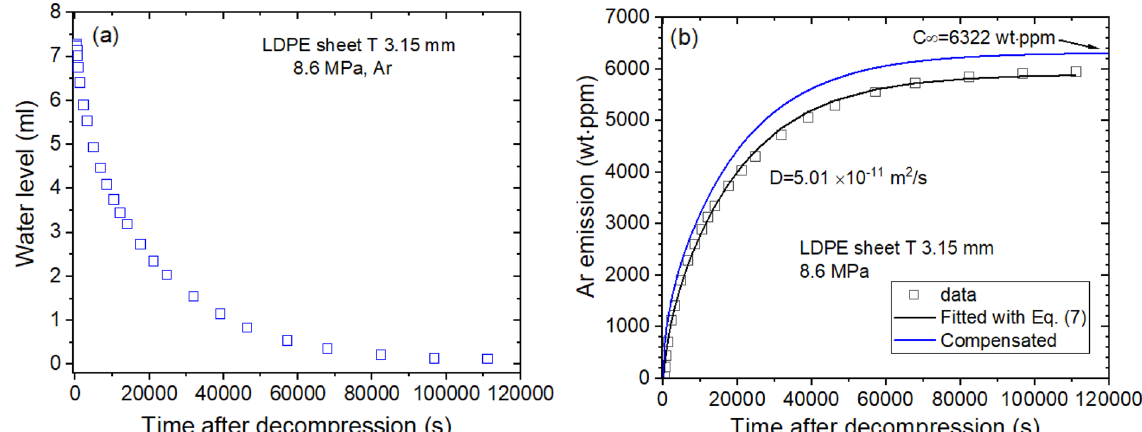
Figure 4. Sequence for obtaining the diffusion parameter in the LDPE sheet. ( a ) Water level versus time after decompression and ( b ) time-varying Ar mass concentration transformed from the water level. As a result of the experimental investigation, the diffusion parameters D and C ∞ are determined using a diffusion analysis program. The blue line is the total compensated emission curve restoring the missing content for lag time. T indicates the thickness of the sheet specimen.